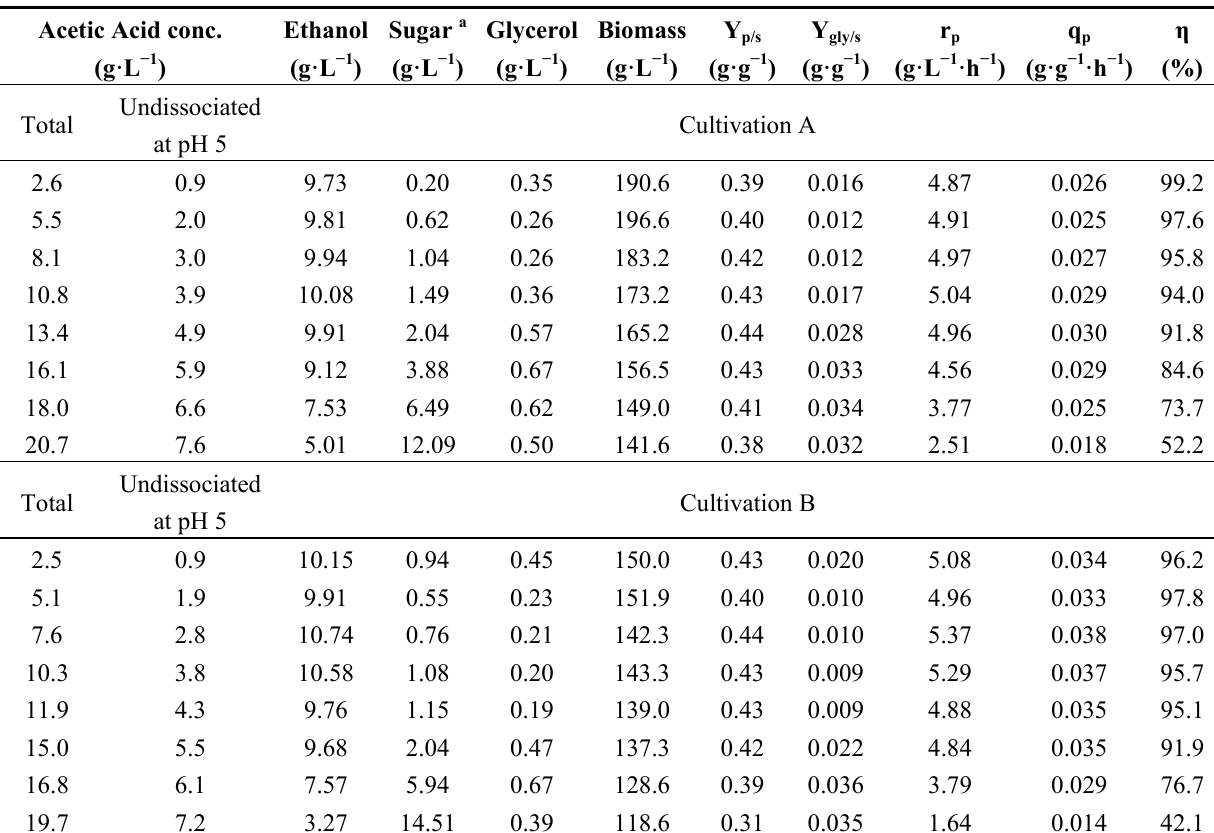
Table 1. Summary of product yields and ethanol productivity during continuous fermentations at very high yeast concentrations. Acetic Acid